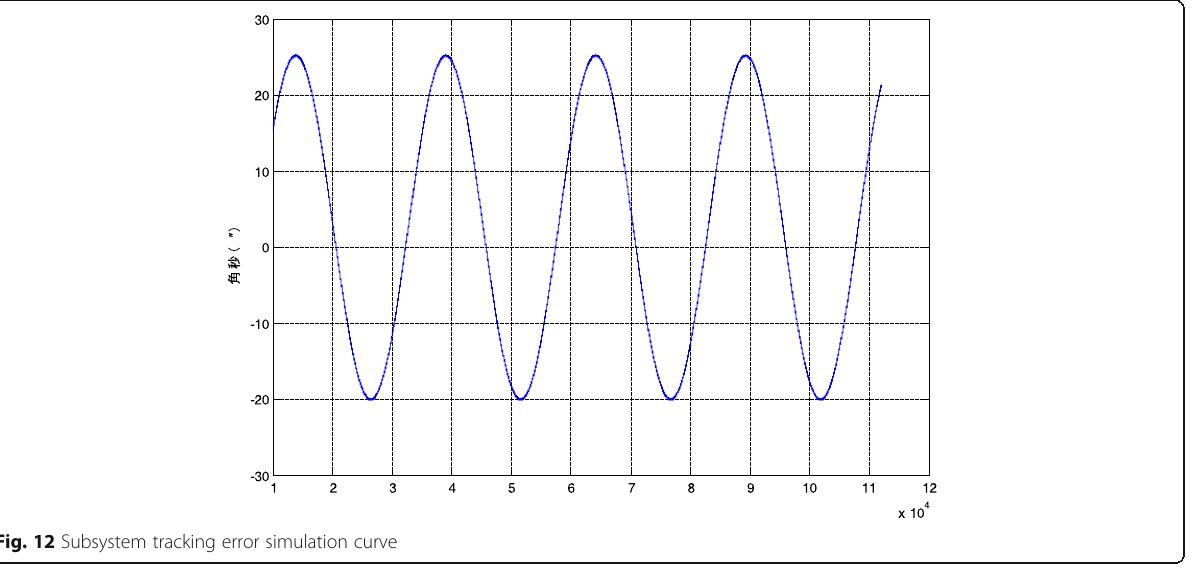
Fig. 12 Subsystem tracking error simulation